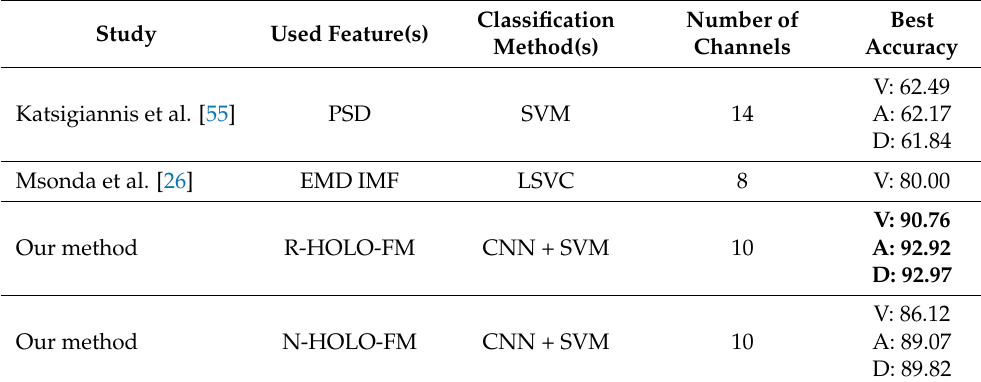
Table 5. Comparison with other studies with reduced channel set on DREAMER dataset.